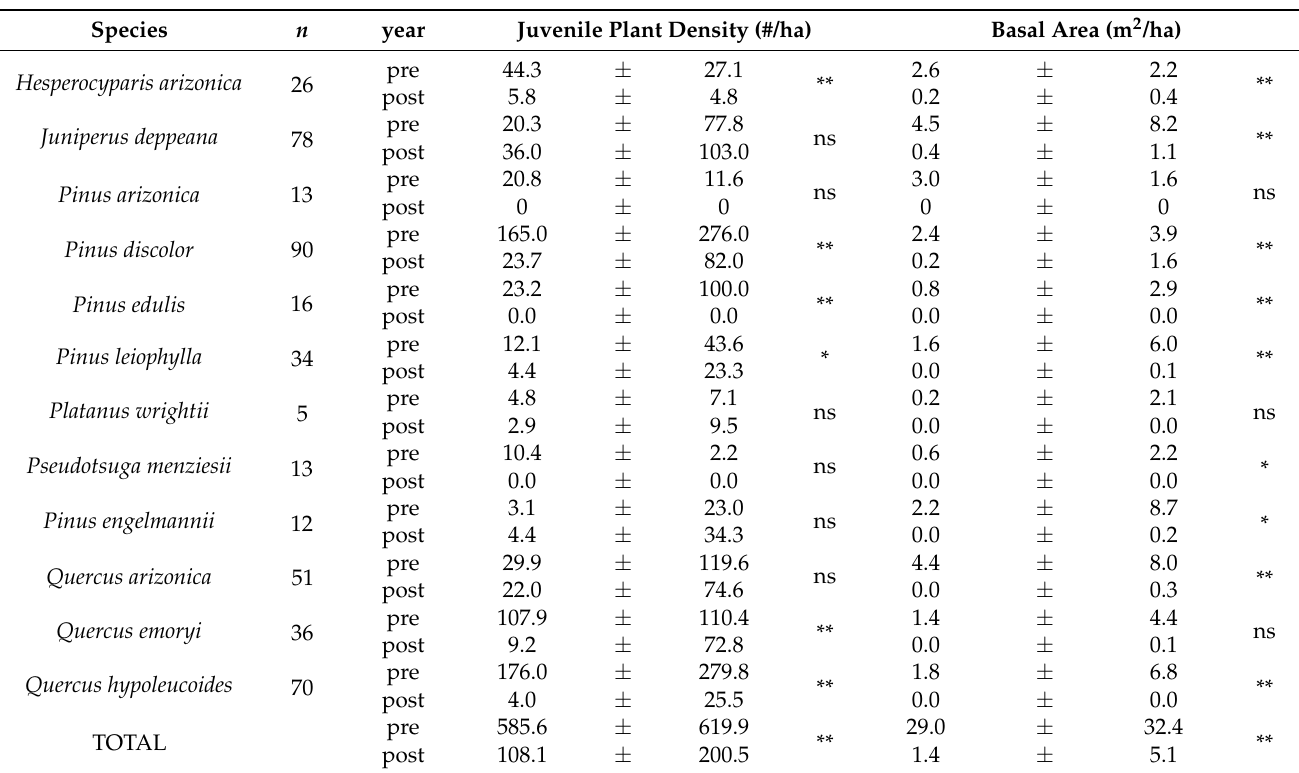
Table 1. Mean juvenile plant density (stems < 10 cm basal diameter) and basal area ( ± 1 S.E.) for major tree species before (2002/3) and after (2017/2018) the Horseshoe Two Fire in Chiricahua National monument, Arizona, USA. Changes in tree density are shown in Table 3 and Figure 4. The number of plots in which each species occurs is indicated in the n column. Significant differences between the pre- and post-sampling interval according to the Wilcoxon Rank Sign Tests are displayed with asterisks (ns = not significant, * = p < 0.05, and ** = p < 0.01). Species n